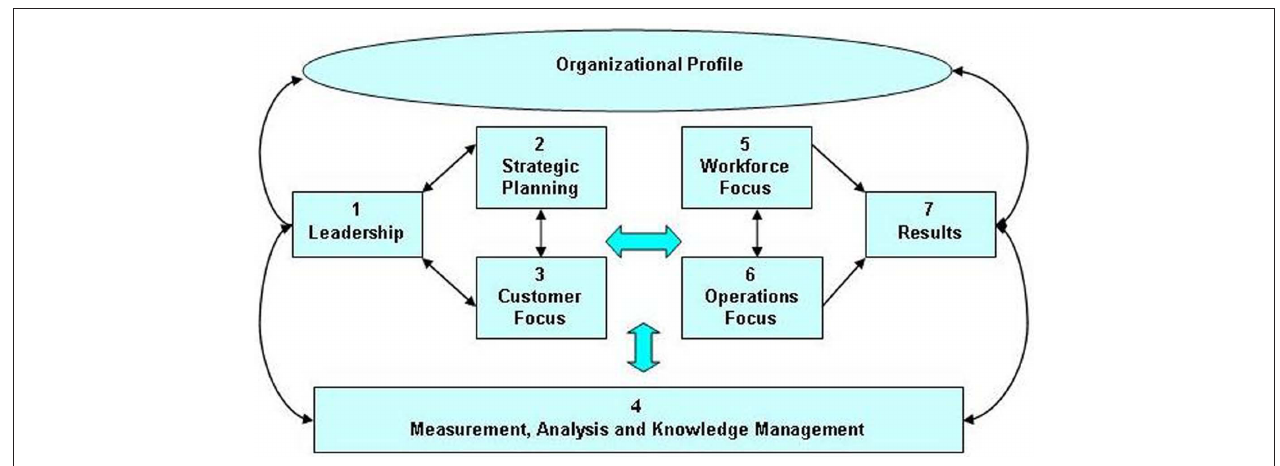
Figure 1 | Baldrige health care criteria for performance excellence framework. Source: National Institute of Standards and Technology, Department of